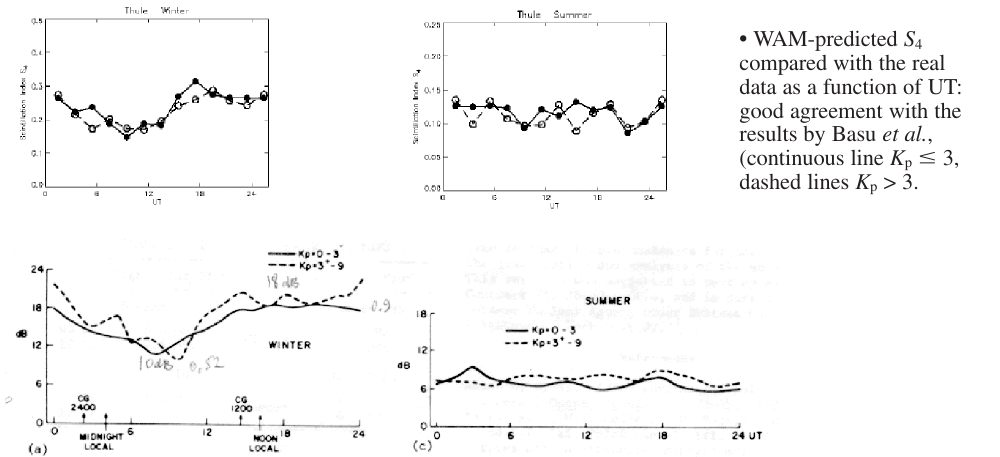
Fig. 11. A preliminary validation study for the model WAM, in which the values of the S 4 index predicted by it are compared with those from real data reported in the paper Su. Basu et al ., Radio Sci., v. 20, 347, 1985 quoted.